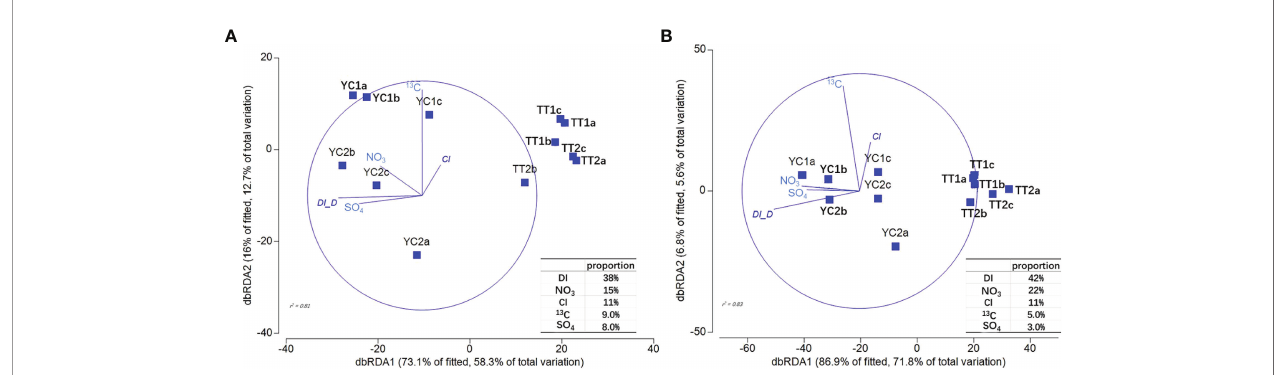
FIGURE 4 | The db-RDA analysis of bacteria (A) and archaea (B) in this study. Photo by Z-Y Zhu.